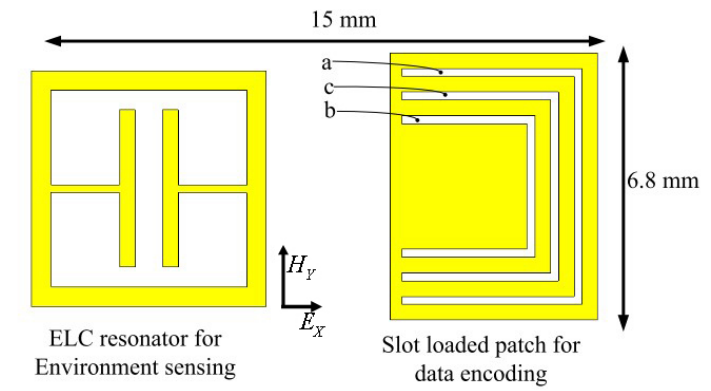
Figure 15. The layout of the chip-less RFID tag humidity sensor [95].